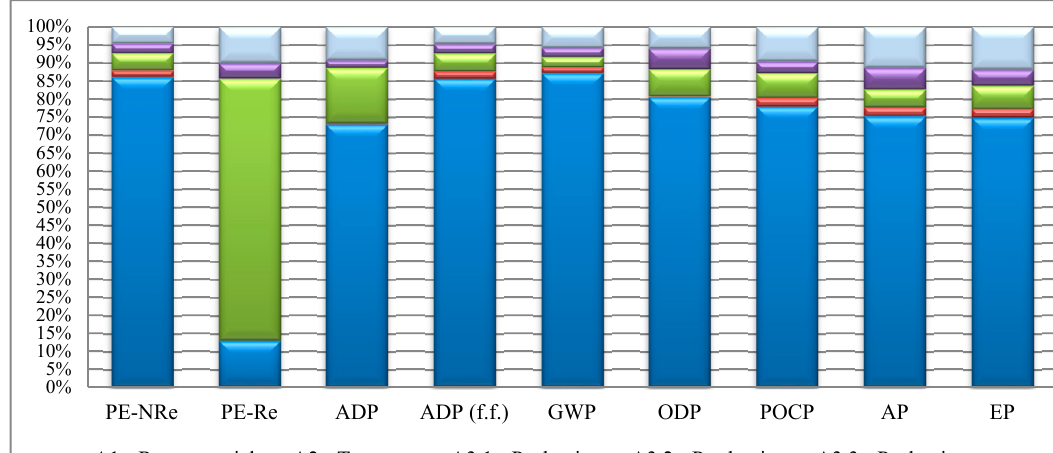
Figure 4. Contribution of each sub-stage of thermal insulation tiles production for environmental impacts.